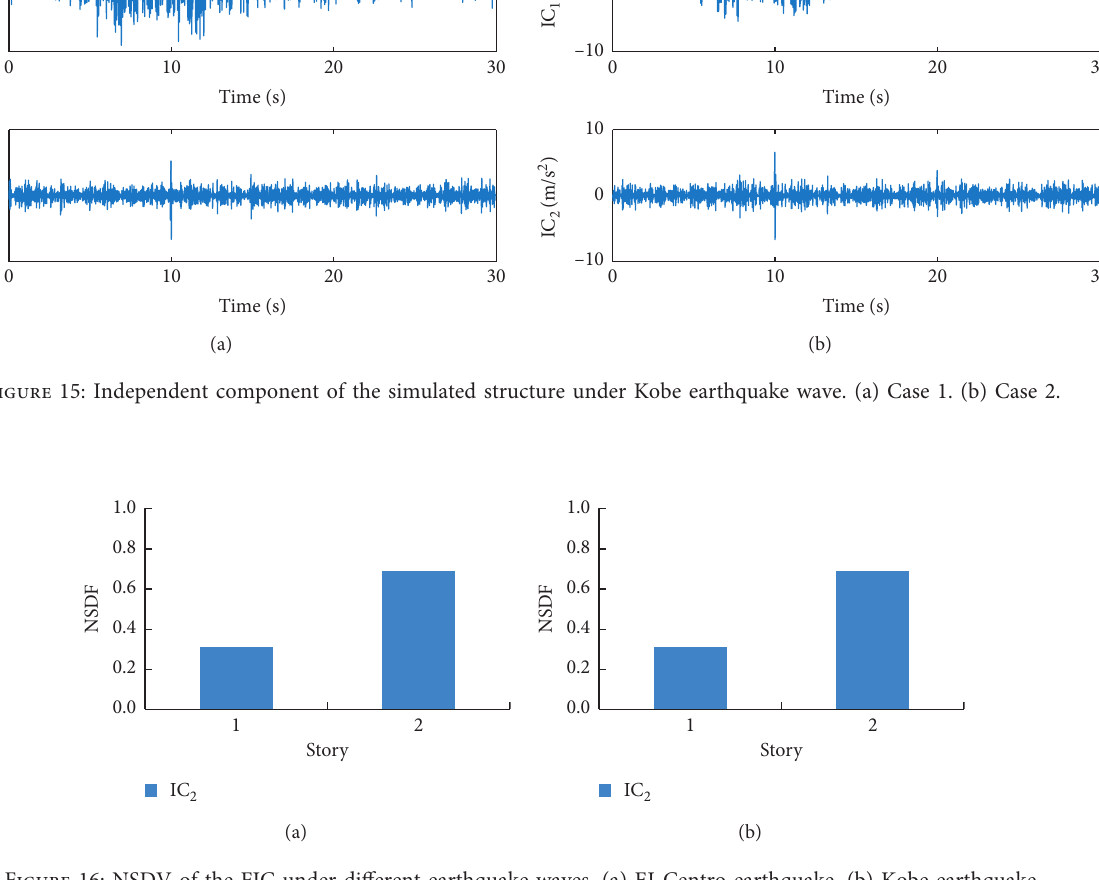
Figure 16: NSDV of the FIC under different earthquake waves. (a) EI-Centro earthquake. (b) Kobe